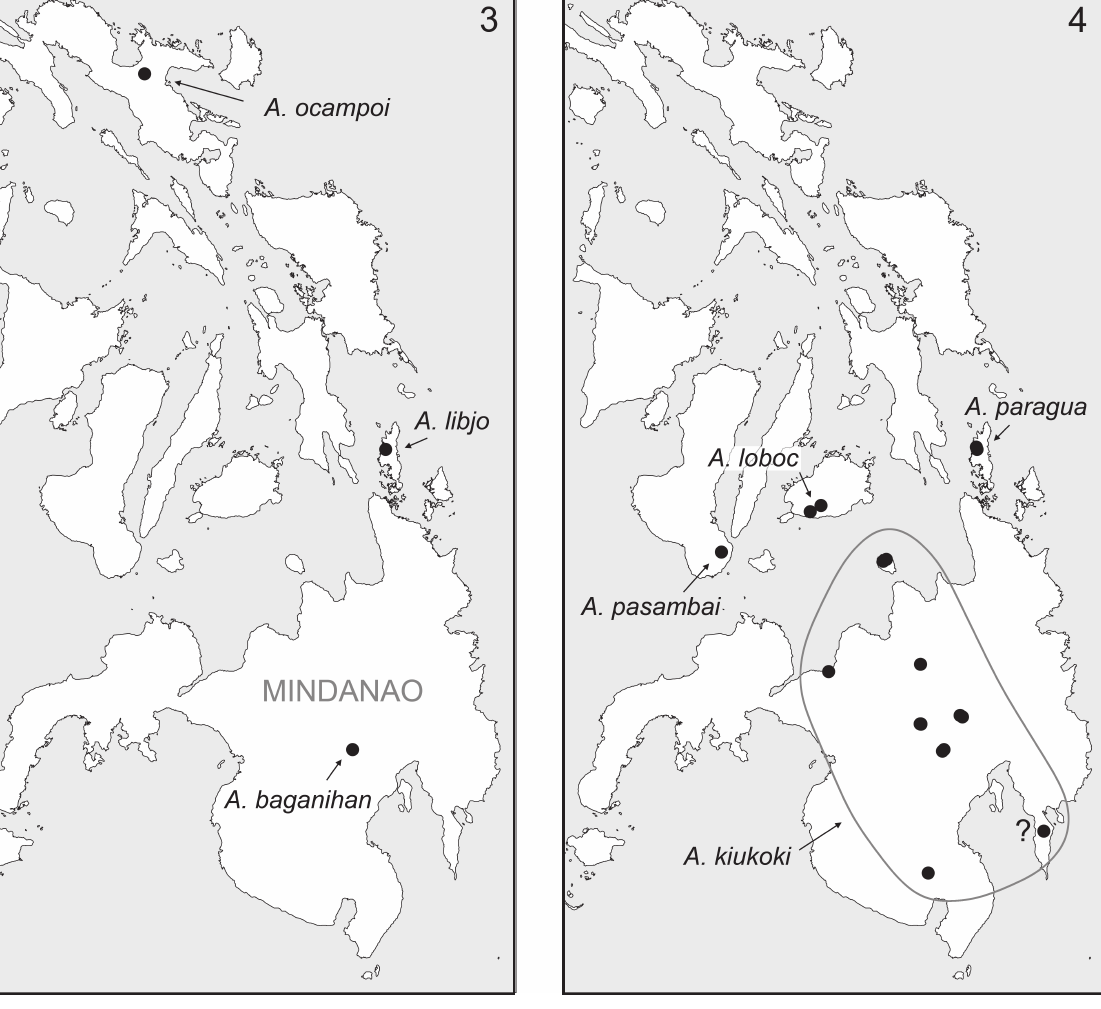
Figs 3–4. Known distributions of the Aetana ocampoi (3) and A. kiukoki (4) groups. The question mark denotes a female specimen assigned tentatively to A.